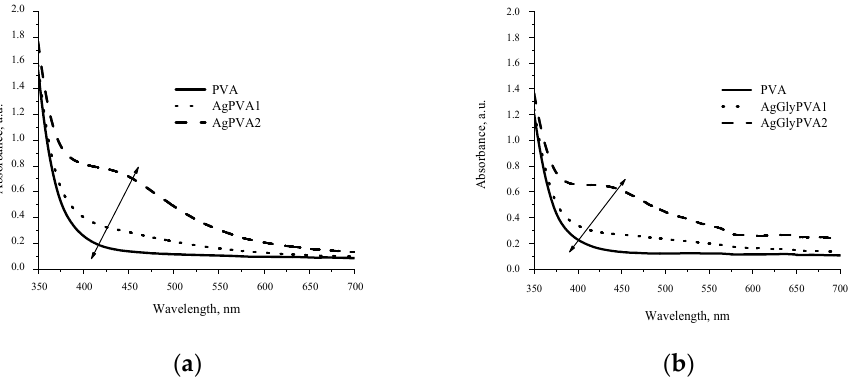
Figure 3. UV- VIS spectra of X-ray-irradiated gels containing two different concentrations of AgNO 3 : ( a ) without additives (AgPVA) and ( b )with glycerol (AgGlyPVA). Both types of gels were irradiated with 5 Gy dose.